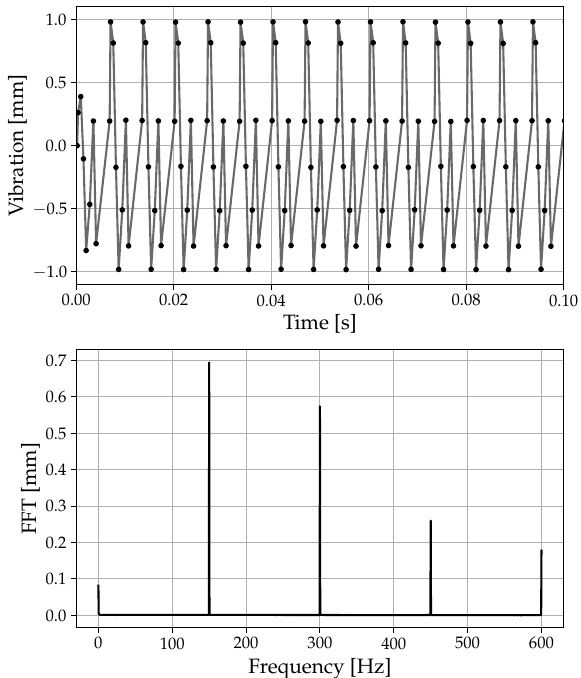
Figure 5. Example of deflection: 9000 to 9500 RPM, f r = 1500 Hz, A = 1 mm: amplitude response and deflection